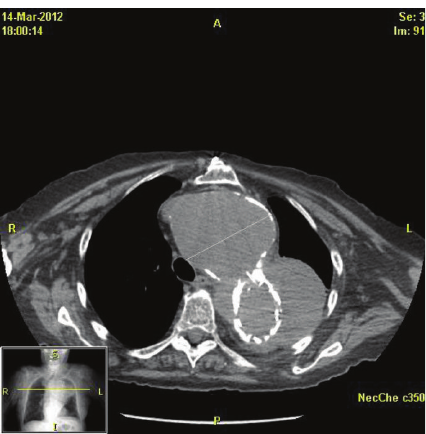
Figure1:Largeacutehematomasurroundingtheproximaldescend- ing thoracic aorta with insinuation of the hematoma into the aortopulmonary window, concerning in appearance for contained